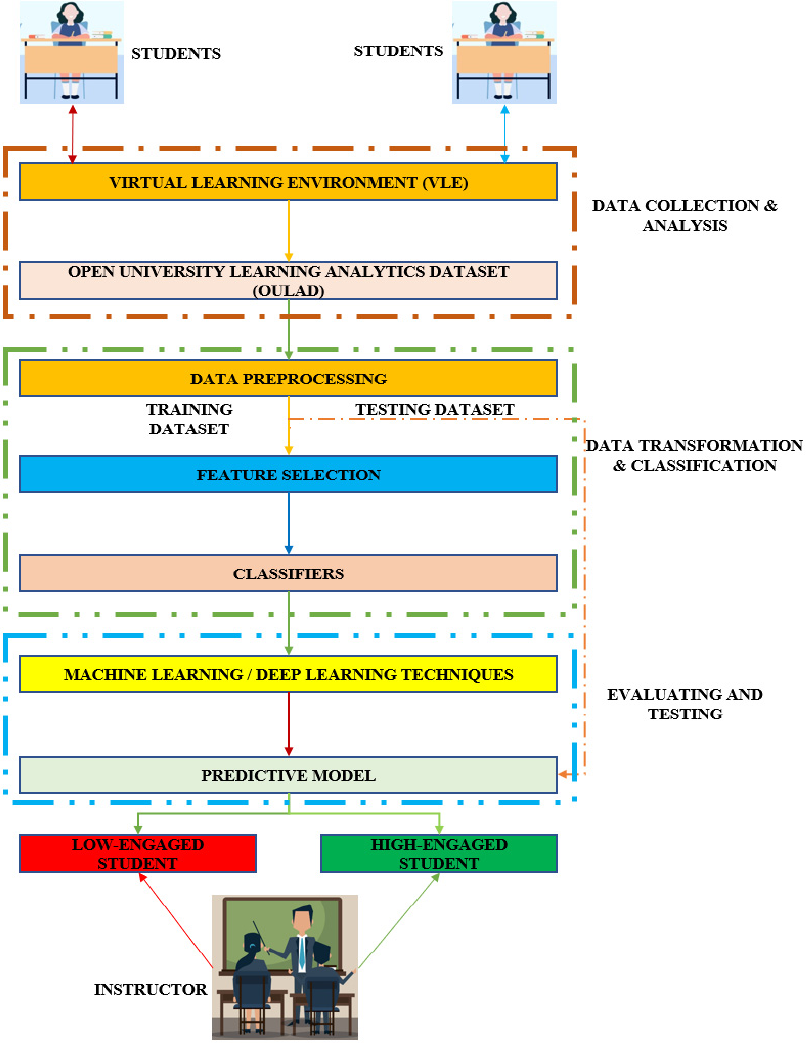
Figure 1. Conceptual Structure for Student Engagement Using ML/DL Methods in a